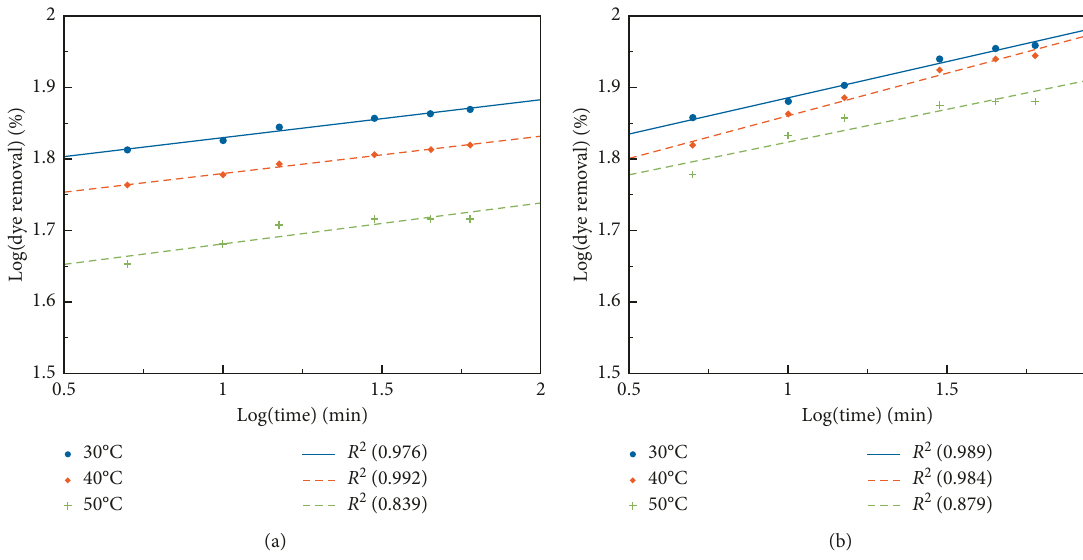
Figure 6: Log (dye removal) (%) versus log time (min) for (a) raw sawdust and (b) chemically treated sawdust.